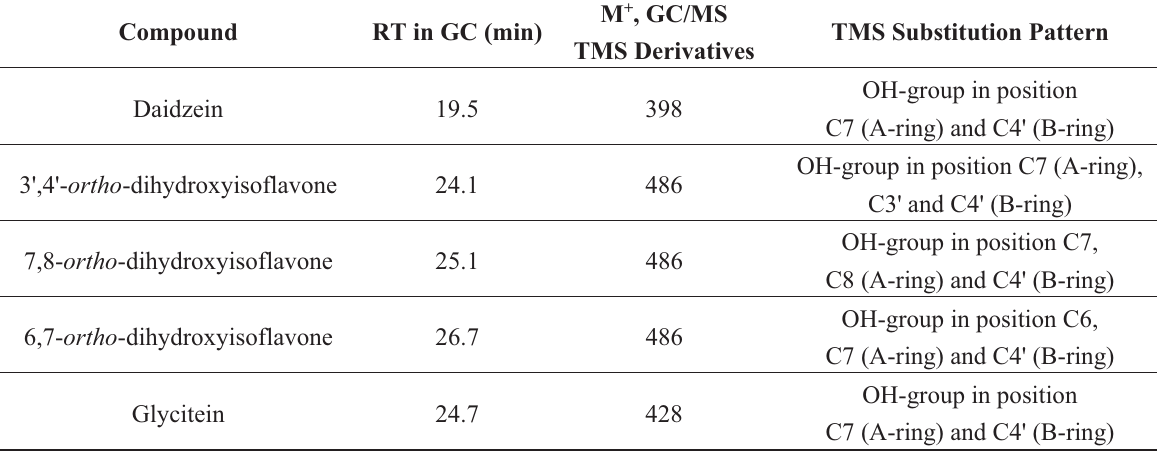
Table 1. Summary of chromatographic retention time and mass value of TMS derivatives.